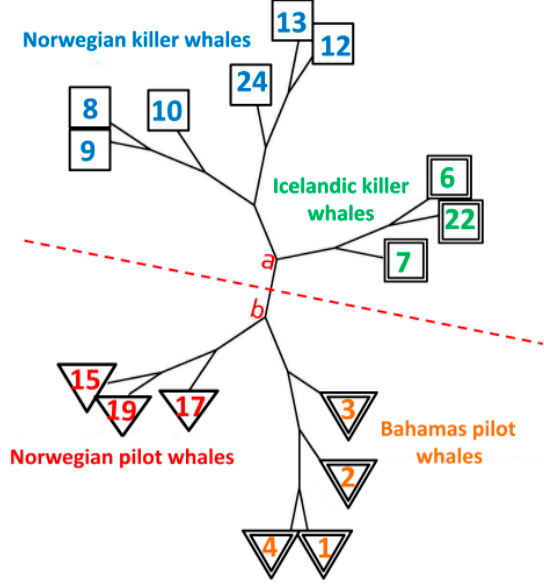
Figure 4. The phylogeny created for whale sub-populations.